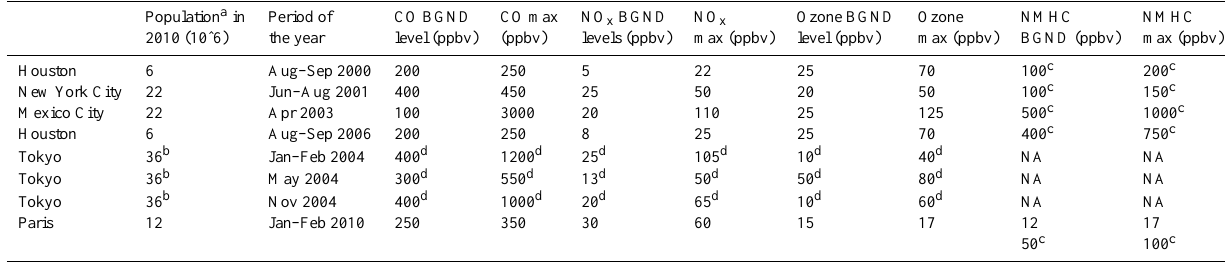
Table 1. Gaseous pollutants levels registered in different urban atmospheres.